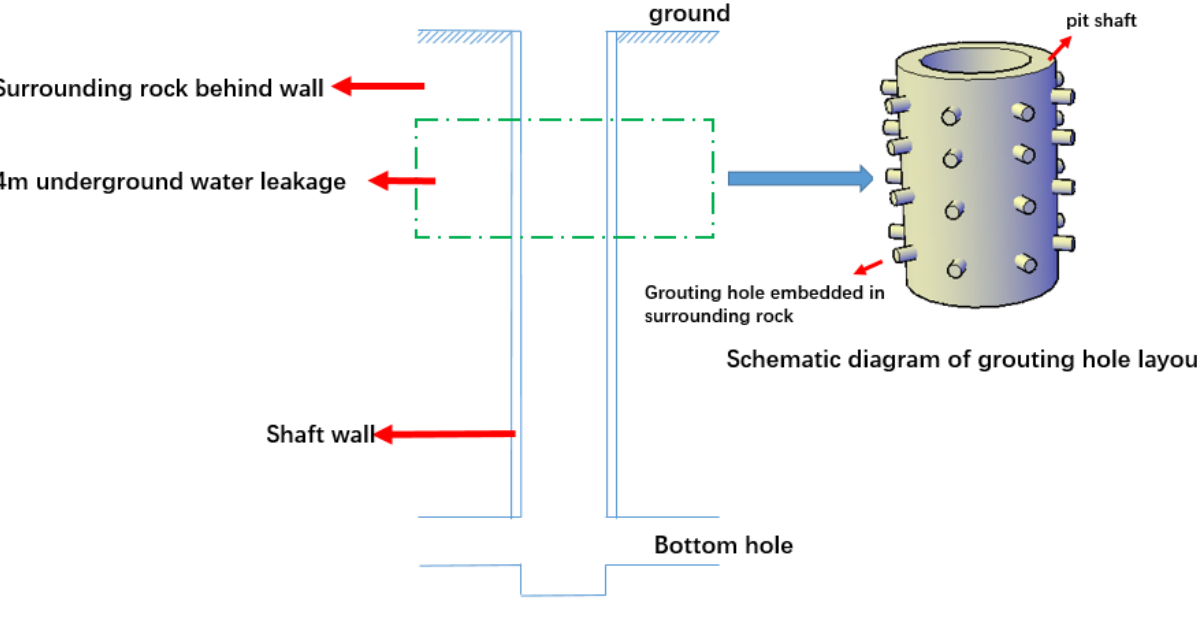
Figure 2. Layout of grouting section and grouting